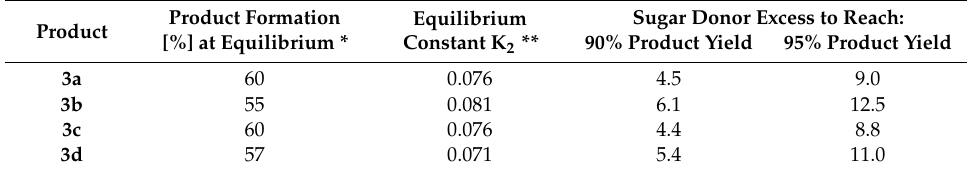
Table 1. Equilibrium state thermodynamic calculations were used to determine appropriate reaction conditions for the maximum conversion of 3 a – d .